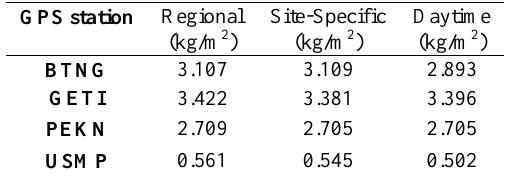
Table 9: Comparison between regional, site-specific and daytime T M models during daytime observation. The RMSE is slightly reduced by using daytime T M model.